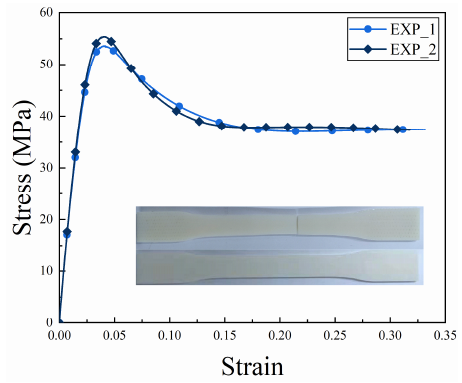
Figure 6. Tensile stress-strain curve of verowhite. Figure 5. Tensile stress-strain curve of Table 1. Mechanical properties parameters of verowhite.